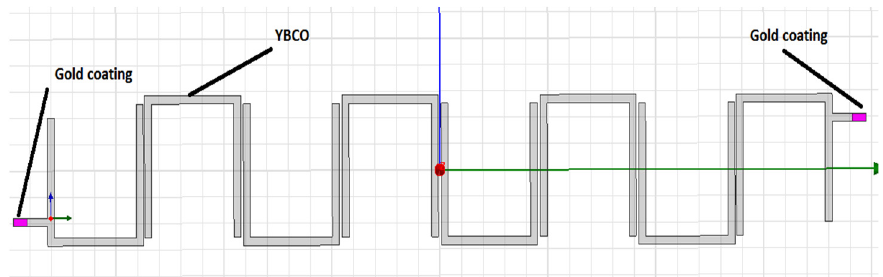
Figure 1. The 8-order hairpin line microstrip geometry of YBCO filter.